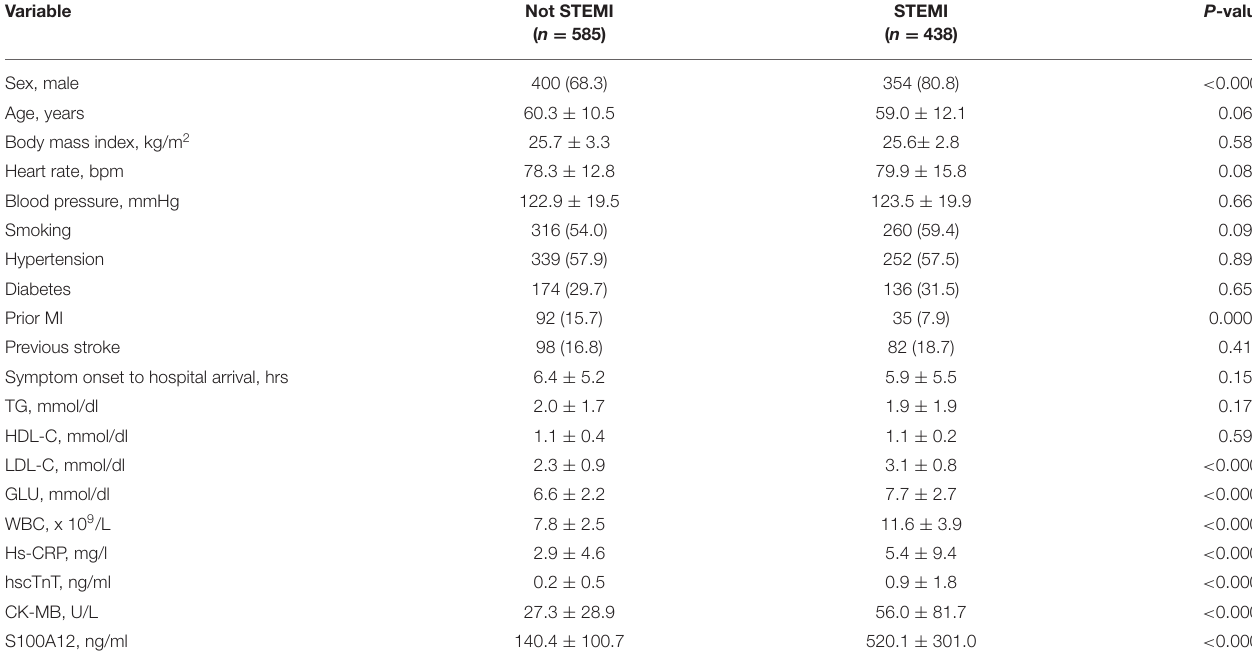
TABLE 1 | Baseline characteristics of the cohort 1 study population. Variable